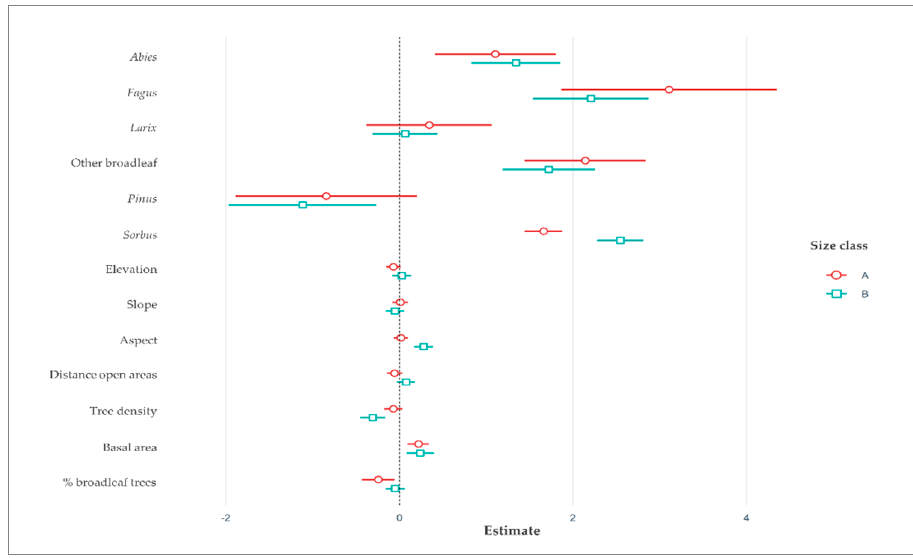
Figure 2. Effect size with standard errors resulting from GLMs for size class A (red circles) and B (blue squares).